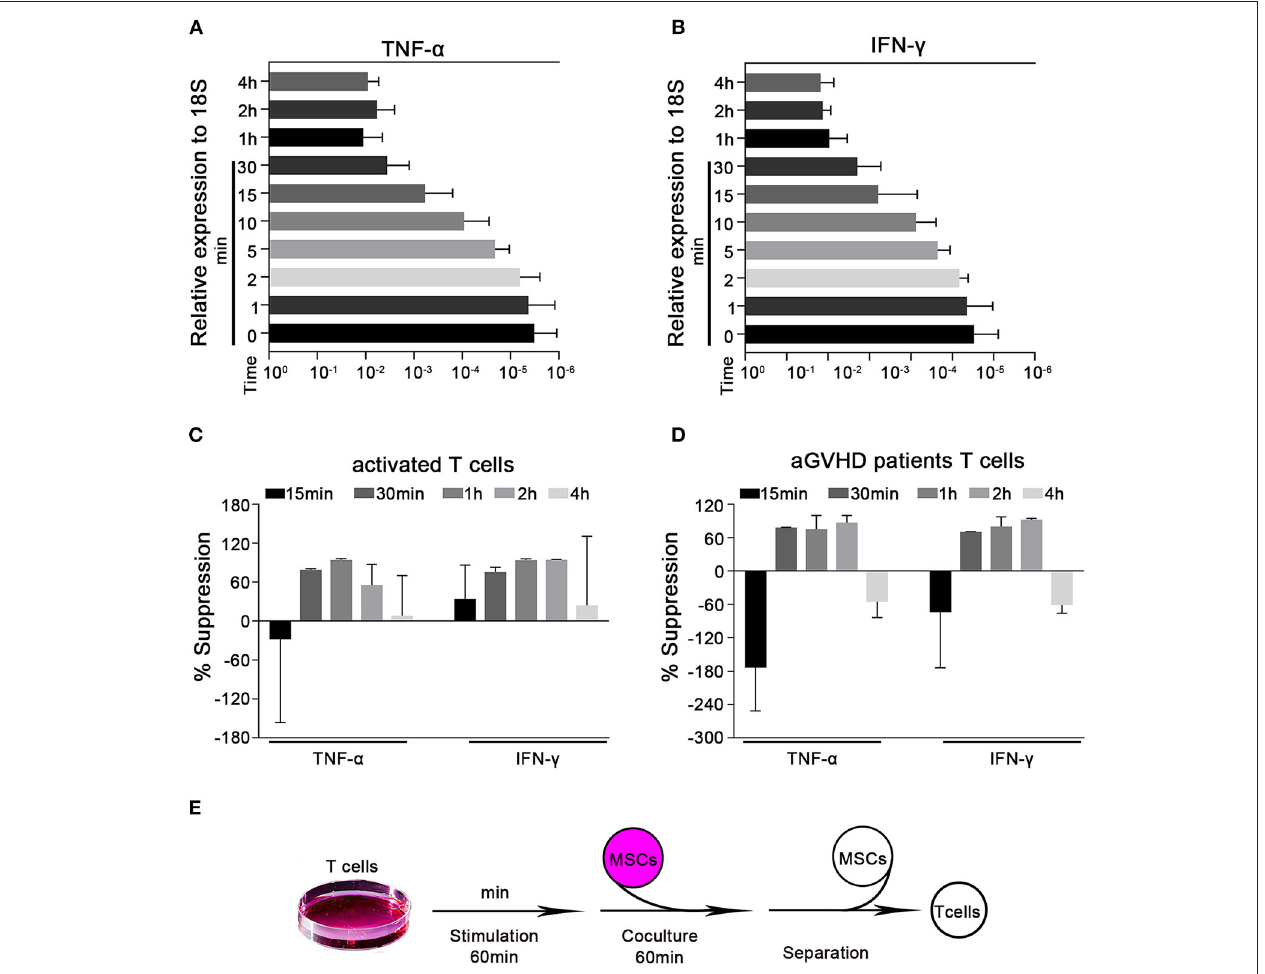
FIGURE 1 | MSCs rapidly suppress the transcription of cytokines in activated T cells. Quantitative reverse transcription–polymerase chain reaction (qRT-PCR) analysis of the mRNA abundances of TNF- α and IFN- γ in activated T cells. (A,B) T cells were stimulated by CD3 mAb and CD28 mAb for 1, 2, 5, 10, 15, and 30min, 1, 2, and 4h. The mRNA abundances of TNF- α and IFN- γ were analyzed, the results are presented relative to the level of the 18S rRNA. (C) Activated T cells from healthy donors were cocultured with MSCs (ratio 5:1) for 15 and 30min, 1, 2, and 4h. The T cells were then isolated and analyzed for the mRNA levels of the indicated cytokines, which are shown as the percentages of suppression relative to the corresponding levels in monocultured T cells. (D) T cells from pediatric aGVHD patients were treated as described in (C) , but without activation. The results are shown as the percentages of suppression by MSCs for the indicated cytokines. (E) Schematic of the experimental protocol: T cells were stimulated for 60min, cocultured with MSCs for 60min (ratio 5:1), and then isolated for subsequent experiments. All experiments were repeated three times. Data are expressed as the means ± SEM from three donors (A–C) or four patients (D)